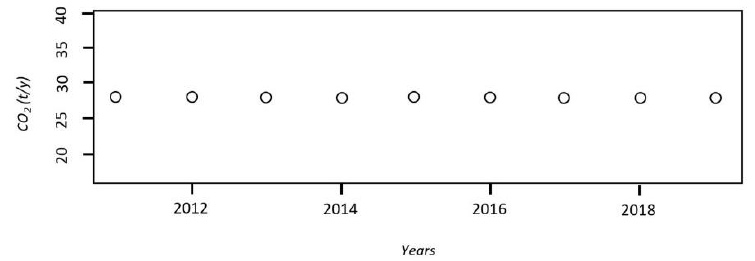
Figure 1. COPERT simulation of the CO 2 emissions by a EURO III bus with a 400,000-km mileage.